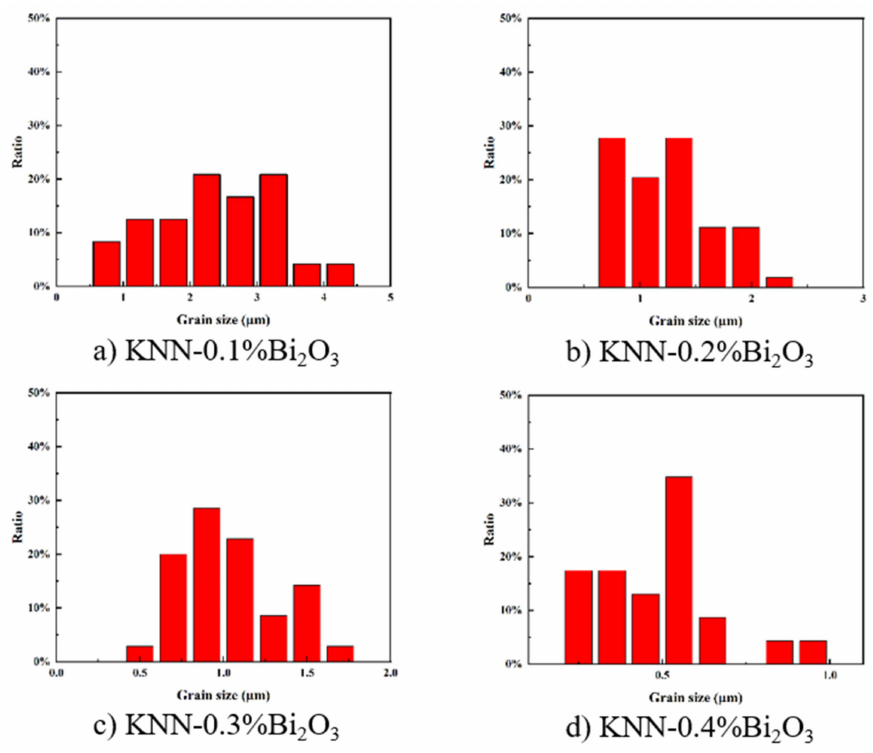
Figure 3. Particle size distribution of KNN-xBi 2 O 3 piezoelectric